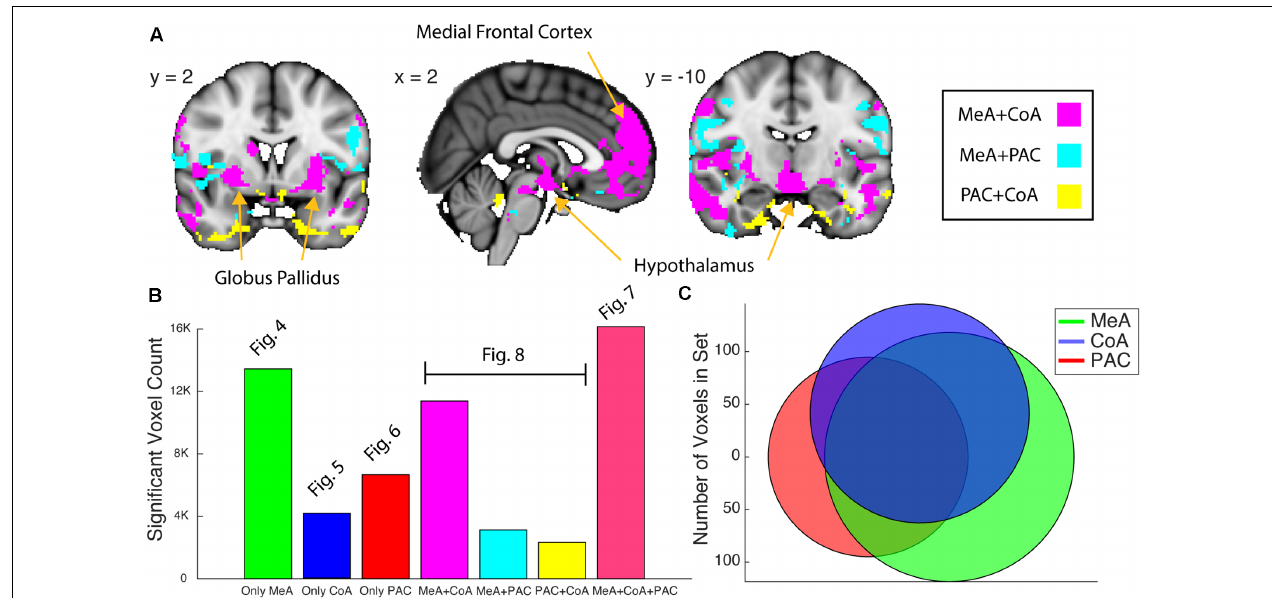
FIGURE 8 | Whole-brain resting connectivity common to two of the three olfactory amygdala subregions. (A) Intersections of resting state networks of olfactory amygdala subregion pairs. Results are overlaid on FSL’s MNI152_T1_1 mm_brain. (B) Bar plot of the number of voxels that shows significant connectivity with each ( Figures 4 – 6 ) and combination (panel A and Figure 7 ) of the olfactory subregions. (C) Venn Diagram of panel (B) . The connectivity maps were thresholded at threshold-free cluster enhancement corrected P <